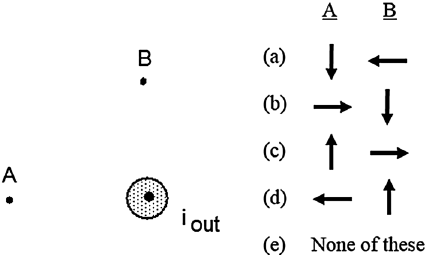
FIG. 8. Physical situation and answers provided for Q27 on the CSEM. FIG. 9. Diagram and answer choices for Q26 on